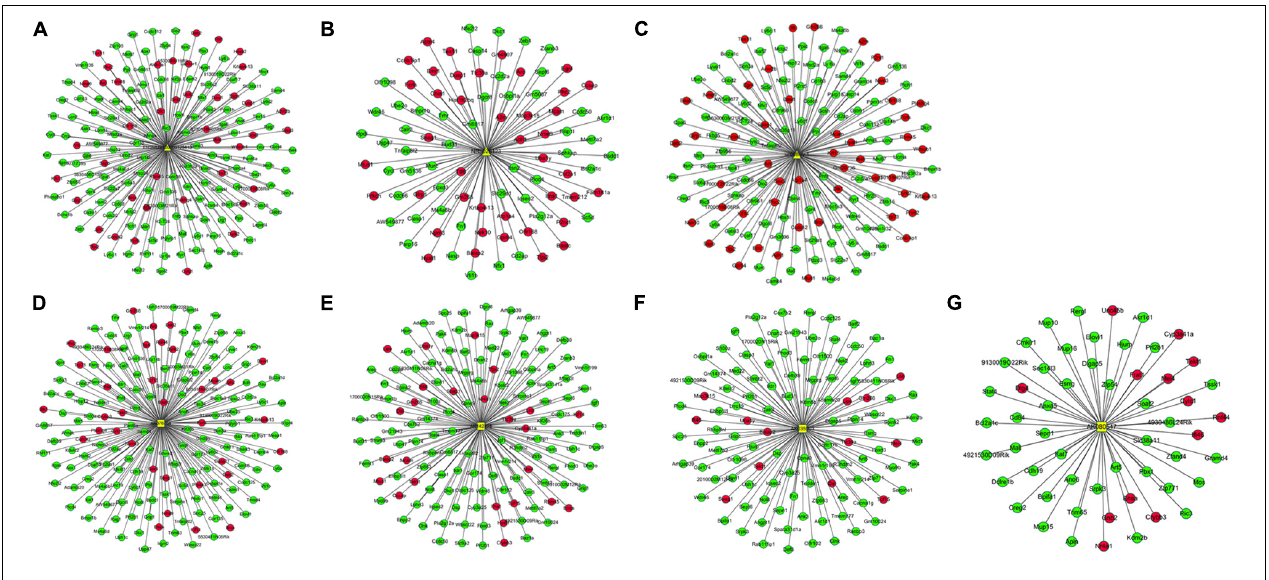
FIGURE 7 | Co-expression network between up- and down-regulated DElncRNAs and DEmRNAs in the Nrf2 (–/–) hippocampus. (A) Subnetwork of ENSMUST00000125413. (B) Subnetwork of NR_028123. (C) Subnetwork of uc008nfy.1. (D) Subnetwork of AK076764. (E) Subnetwork of AK142725. (F) Subnetwork of AK035903. (G) Subnetwork of AK080547. The triangles, squares represent up- and down-regulated DElncRNAs, and ellipses represent DEmRNAs in the Nrf2 (–/–) hippocampus. Red and blue color represent up- and down-regulation in the Nrf2 (–/–) hippocampus, respectively.